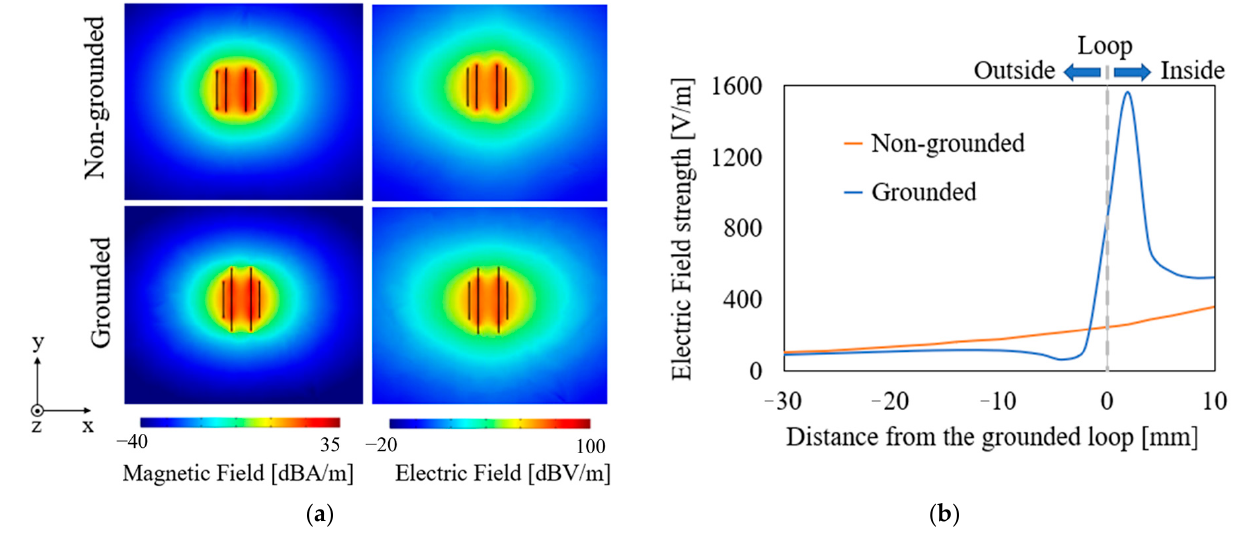
Figure 8. Electromagnetic-field distribution of two 13.56-MHz MRC-WPT systems without a human model when the input power is 1 W and the transmission distance d = 9 cm. ( a ) Electric and magnetic field distributions around the WPT systems. ( b ) Electric field on a horizontal line. The gray circle illustrates the location of the grounded loop.